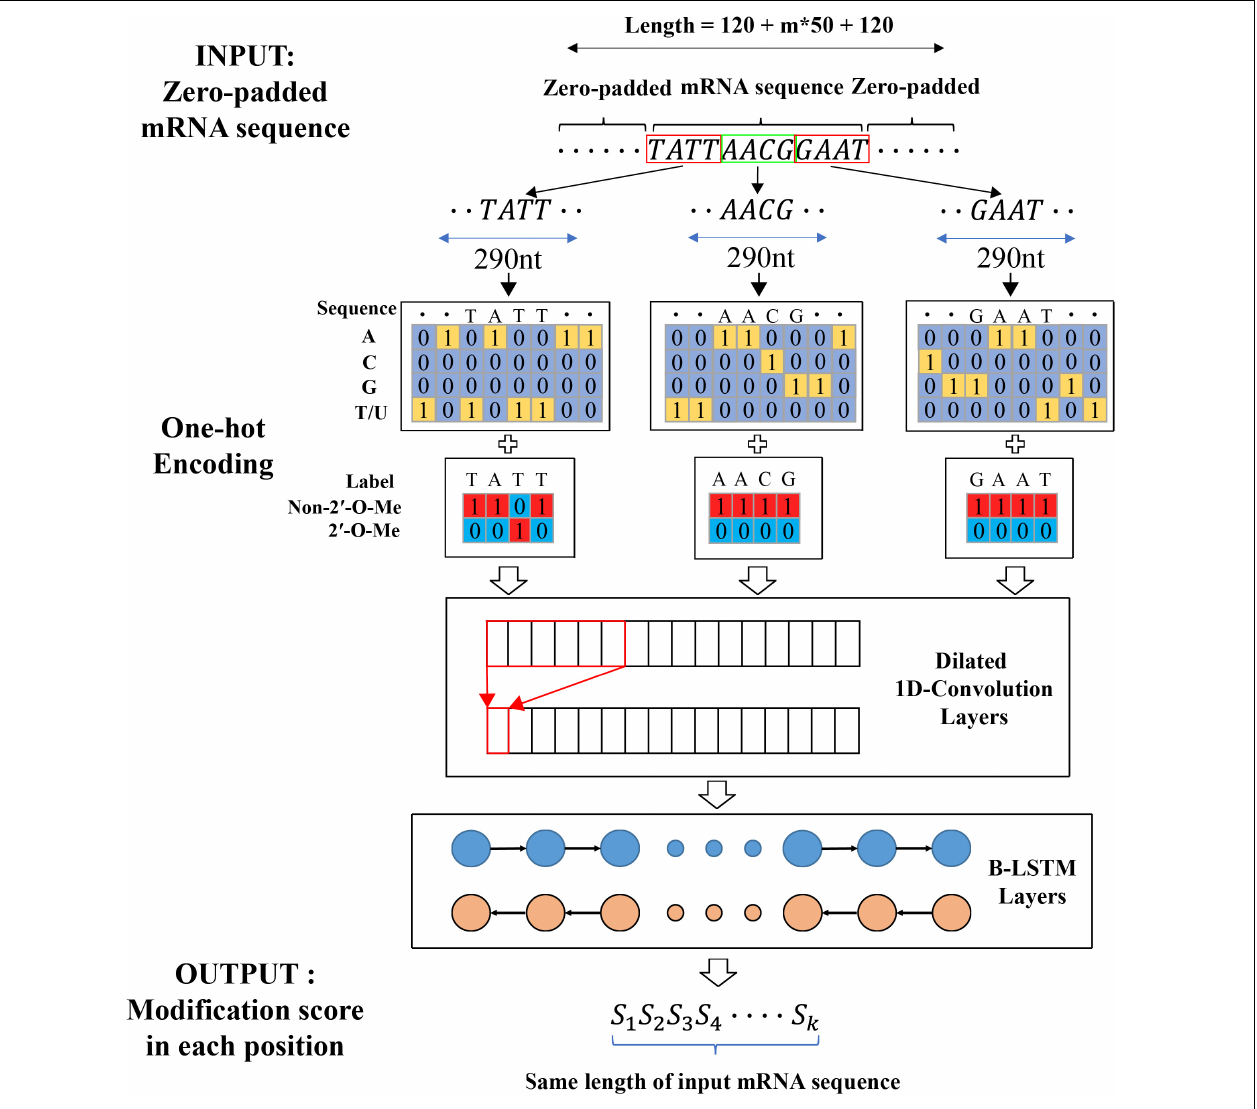
FIGURE 1 | The workflow of predicting 2 (cid:48) -O-Me sites from primary mRNA sequences. For splitting the input mRNA sequence into blocks, DeepOMe uses flanking sequence length of 120 and then predicts whether each position in extracted blocks contains 2 (cid:48) -O-methylation.